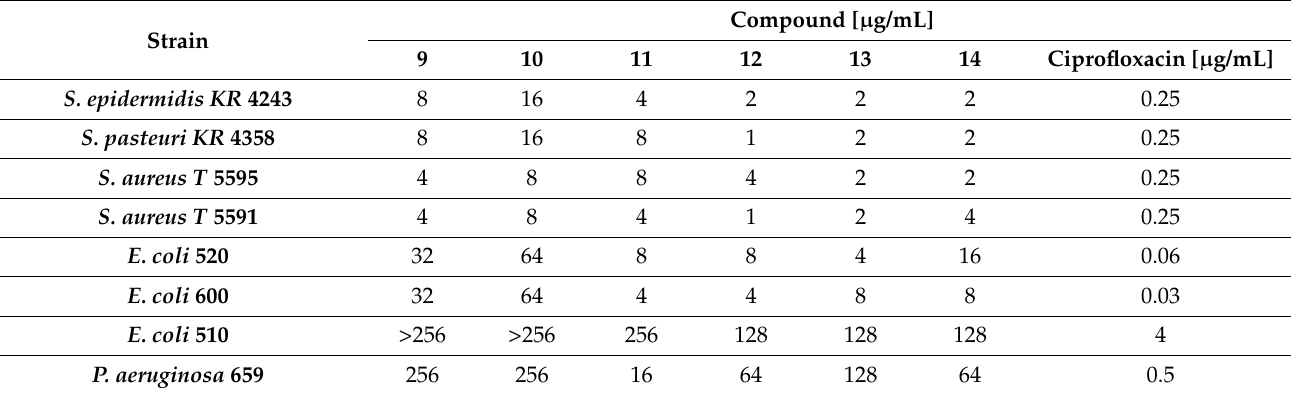
Table 5. Activity of Ciprofloxacin thymol derivatives against clinical bacteria strains, expressed by minimal inhibitory concentrations ( µ